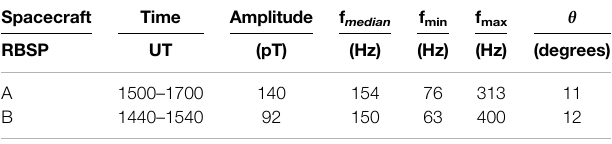
TABLE 1 | Average wave parameters obtained from both Van Allen Probe spacecraft during the event interval. θ is the wave normal angle. Spacecraft